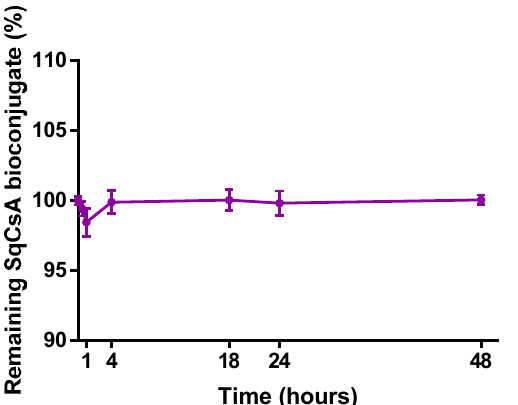
Figure 4. Remaining SqCsA bioconjugate in fetal bovine serum for 48 h. We see no degradation of the bioconjugate. Data represent mean ± SD of three replicates.